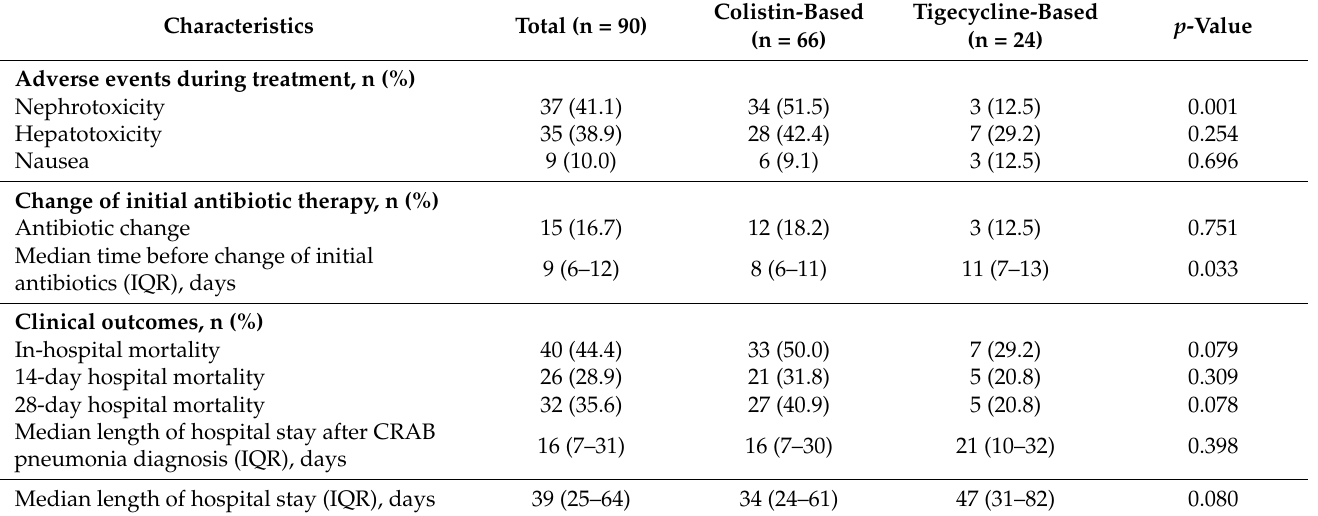
Table 2. Comparison of clinical outcomes between the meropenem–colistin and meropenem–tigecycline groups in patients with carbapenem-resistant Acinetobacter baumannii